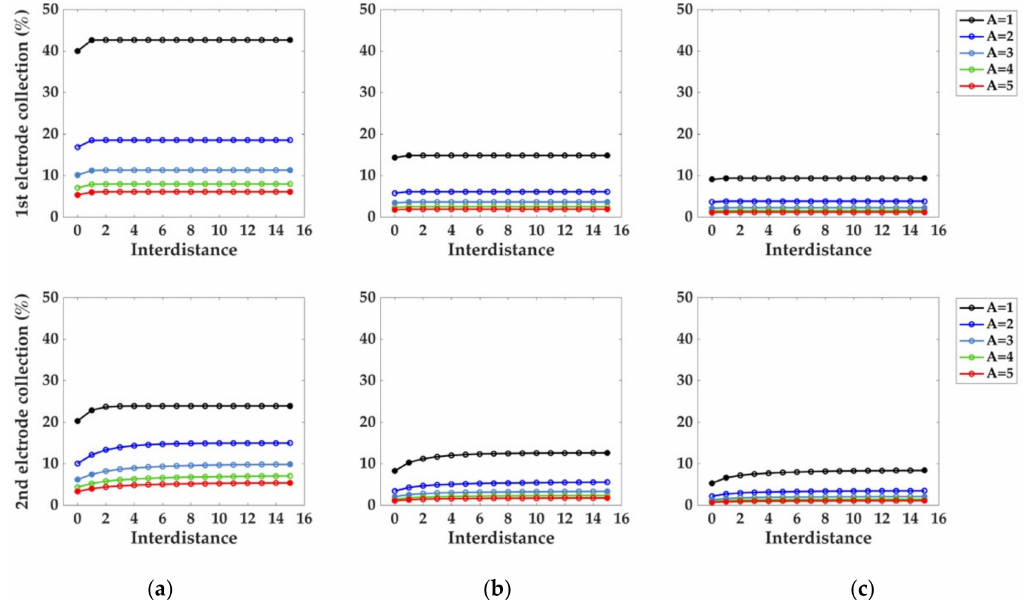
Figure 7. Collection percentages for Pe ( a ) 10, ( b ) 50 and ( c ) 100 calculated at the second electrode of the multielectrodic configuration. Five channel heights A were considered. The reported values were obtained setting the channel length to the fixed value of L = 20 du. Filled markers instead, represent control points from different simulations at A = 1, 3, 5 du which were performed to evaluate the presence of relevant border effects. This was achieved increasing the distances between the electrodes and the left and right borders of the channel, from 1 and 2 du to 4 and 9 du respectively (channel length L set to L = 30 du); no significant changes in collection percentages were detected. The mesh size d = 0.02 du was set according to the mesh convergence criterion of Figure 3.